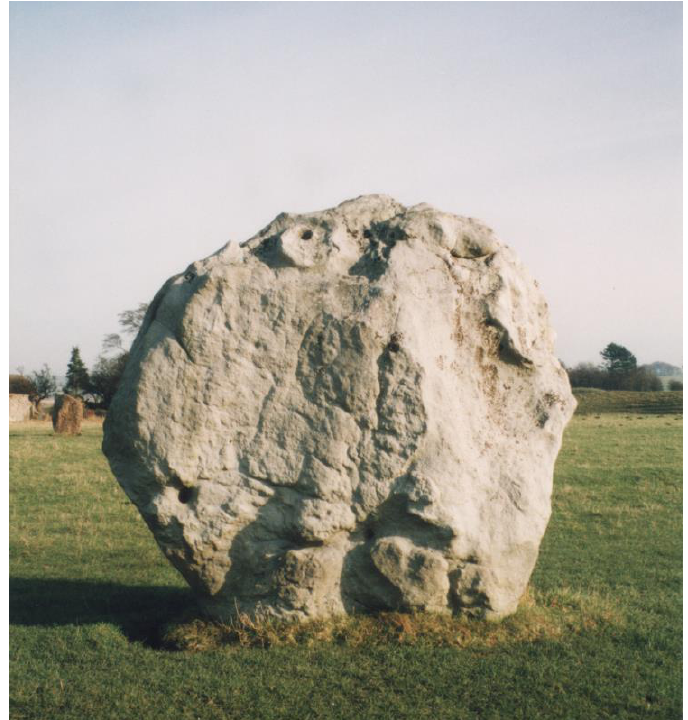
Figure 22. The roundish Stone 105 of the South Circle at Avebury was set to align with the Obelisk such that at the summer solstice sunrise the Obelisk shadow would fall upon it (compare with the plan in Figure 20). (Author’s